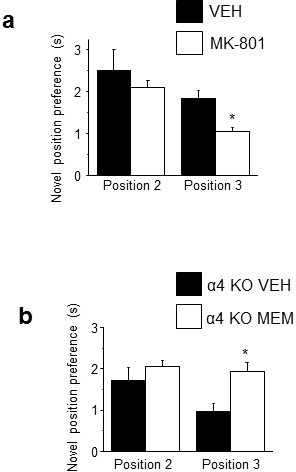
NMDAR antagonist treatment alters behavioral flexibility.Treatment with MK-801 or memantine during puberty, to increase NR1-NMDAR expression or decrease NMDAR activity (Gao and Tamminga, 1995; Cole et al., 2013), respectively, produces opposite effects on behavioral flexibility tested using MPORT post-pubertally. (a) Post-pubertal increases in spine density produced by pubertal treatment with MK-801 resulted in a decrease in position preference for trial 3 of MPORT, reflecting a reduced ability to re-learn object position. Position 2: student’s unpaired t-test, t(12)=0.07, p=0.95; Position 3, t(12)=2.47, p=0.03*, power=0.92 (n=7/group) *p<0.05 vs. Veh. (Figure 5—figure supplement 1—source data 1) (b) Post-pubertal decreases in spine density produced by pubertal treatment of α4 KO mice with the NMDAR antagonist memantine resulted in an increase in position preference for trial 3 of MPORT, reflecting an increased ability to re-learn object position. Position 2: student’s unpaired t-test, t(12)=0.54, p=0.60; Position 3, t(12)=4.32, p=0.0005*, power=0.99 (n=8/group) *p<0.05 vs. Veh. (Figure 5—figure supplement 1—source data 2)DOI:
http://dx.doi.org/10.7554/eLife.15106.03410.7554/eLife.15106.035Figure 5—figure supplement 1—source data 1.Learning acquisition for positions (Pos) 2 and 3 for the multiple placement object relocation task (MPORT).Ratio of time spent for the moved versus unmoved object for post-pubertal mice treated with MK-801 during the pubertal period.DOI:
http://dx.doi.org/10.7554/eLife.15106.03510.7554/eLife.15106.036Figure 5—figure supplement 1—source data 2.Learning acquisition for positions (Pos) 2 and 3 for the multiple placement object relocation task (MPORT).Ratio of time spent for the moved versus unmoved object for post-pubertal α4 KO mice treated with memantine during the pubertal period.